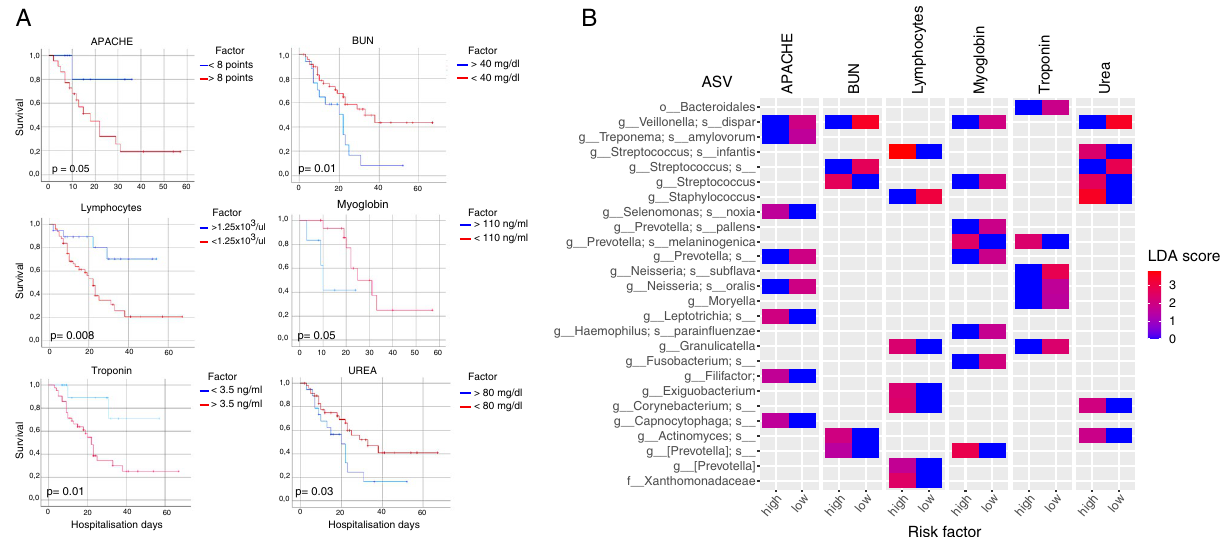
Figure 4. Correlation between clinical variables affecting probability of survival and bacteria in the respiratory microbiota. ( A ) Kaplan–Meier curves for the clinical variables with a statistical significant difference in the probability survival. Variables were classified into two categories specified in the legend “factor”. All curves were constructed with hospitalization days and outcome (either deceased or alive). ( B ) Differentially abundant microbes associated with patients with the different risk factors for the clinical variables obtained through Kaplan–Meier curves. Risk factor (either high or low) corresponds to the result of the survival curves (panel A). ASV Amplicon Sequence Variant, APACHE Acute Physiology and Chronic Health Evaluation, BUN Blood Urea Nitrogen. Color code corresponds to the LDA score obtained from LefSe analysis. Only features with a LDA score higher than 1.5 and a p < 0.01 were